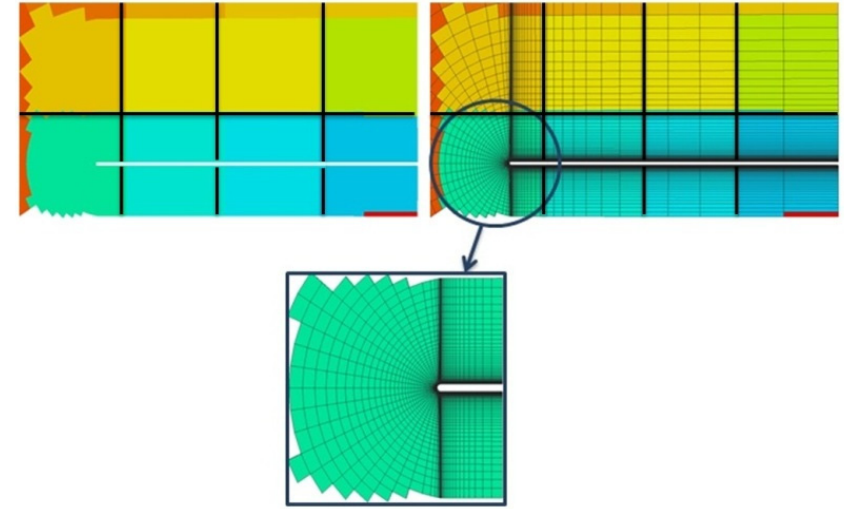
Figure 3. A uniform grid and one macro cell (closeup).